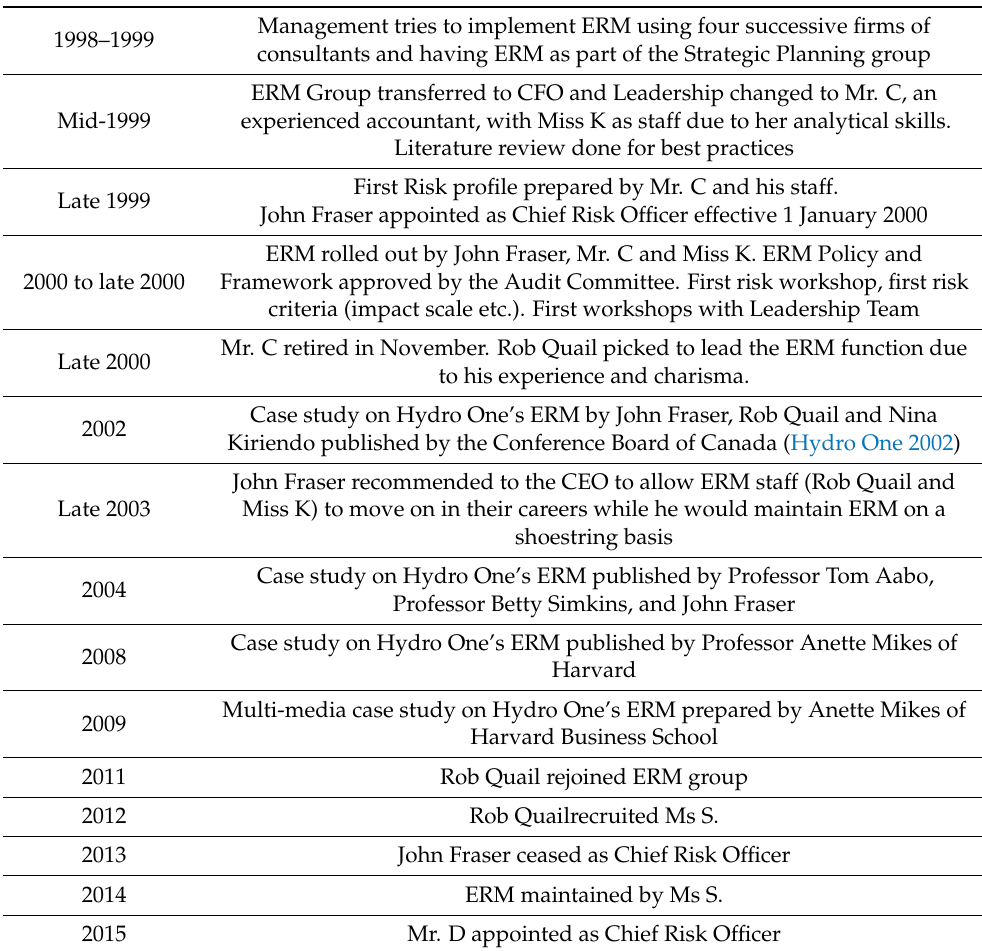
Table 1. Timeline for ERM at Hydro